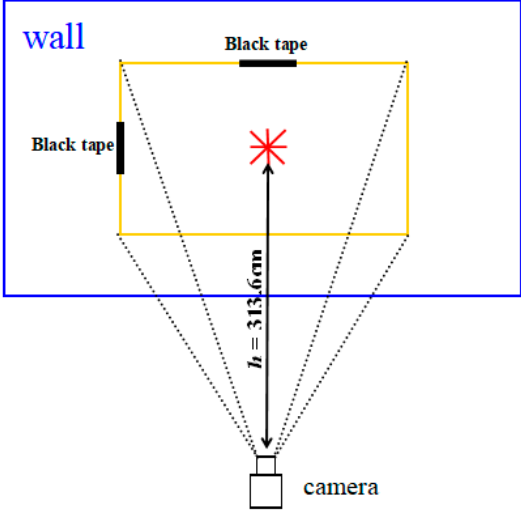
Figure 6. Measurement of the field angle. The blue frame is the wall, the yellow frame is the field of view of the camera, and h is the vertical distance from the camera to the center of the field of view. The center of the red UK-flag shaped is the center of the field-of-view, and black tapes are attached to the center of the upper and left boundaries of the field–of-view. Table 1. Measurement results of field angle at different distances h.